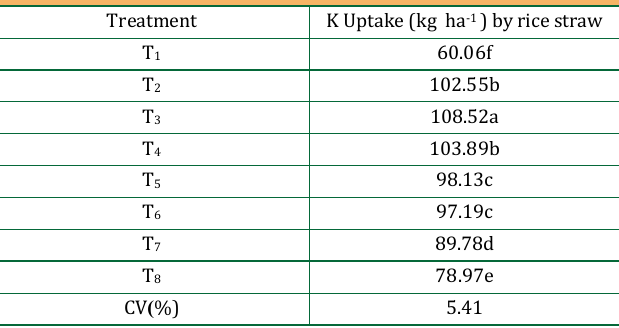
Table 6: Total potassium uptake of BRRI dhan49 as influenced by Banana leaves and chemical fertilizers